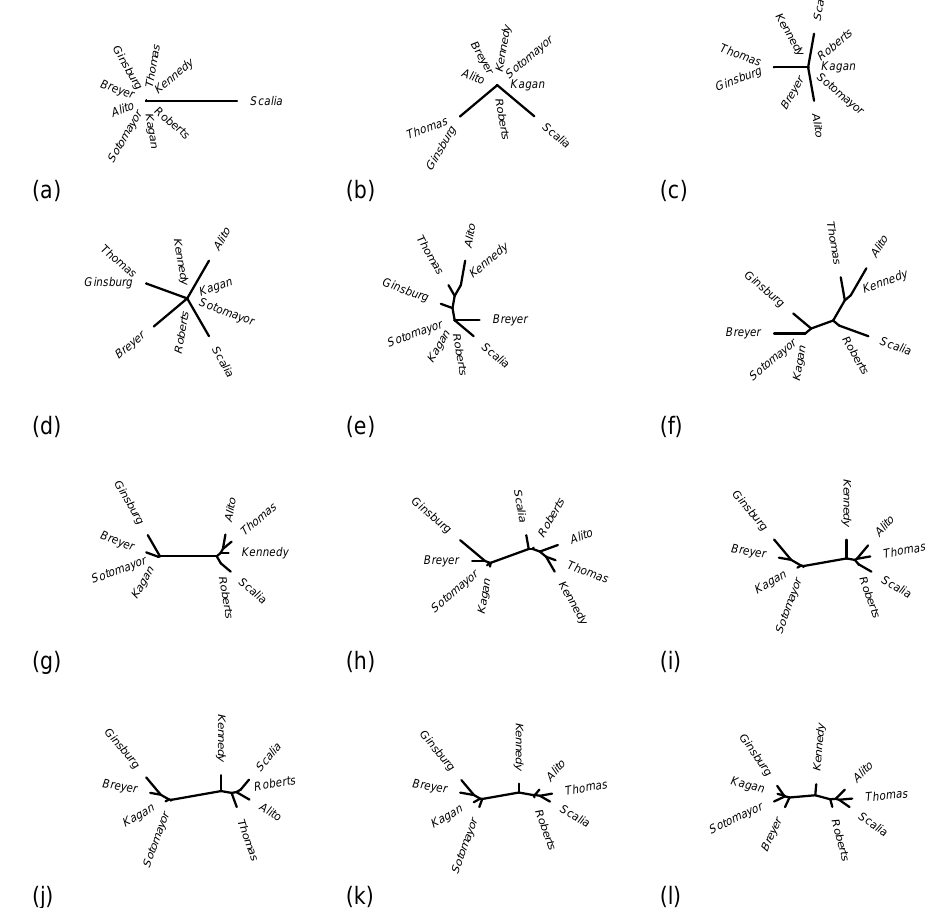
Figure 14. Evolution of the 2010–2016 Roberts 4 Court as seen by tracking the judicial trees as cases are included one at a time. The trees pictured here show the junctures where the tree undergoes a substantive